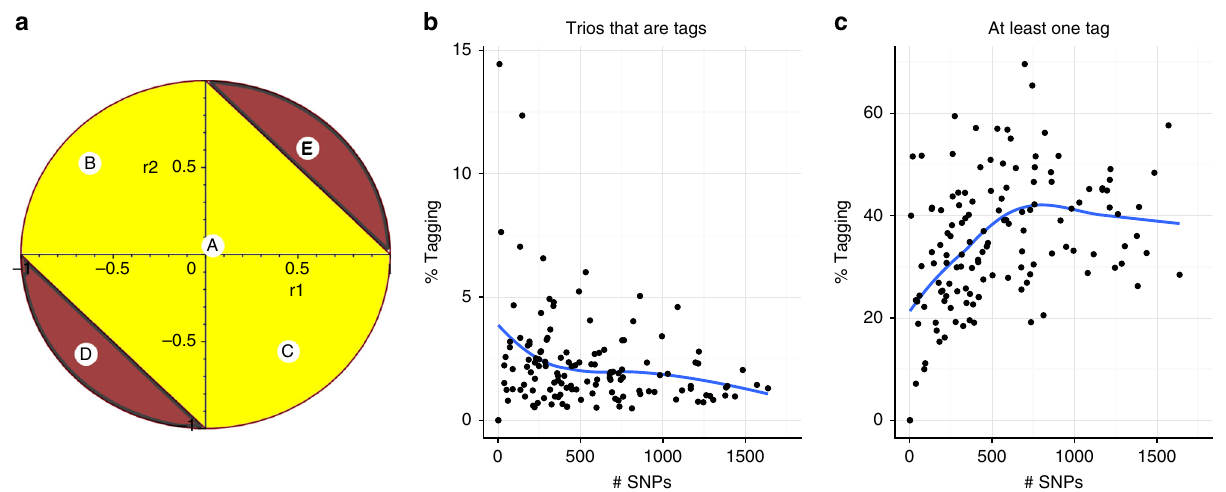
Fig. 2 Potential frequency of joint tagging. We consider the patterns of three-way LD between each possible trio of SNPs, nominating the fi rst two as causal, and the third as a potential tag. a For each pair of potential causal SNPs, we can predict whether the third SNP is a tag according to the pairwise correlation between that SNP and the two potentially causal SNPs (r1, r2). Red (yellow) areas indicate settings where the third SNP is (is not) a potential tag for SNPs 1 and 2. In this example, the potentially causal SNPs have equal MAF, equal effect on disease risk (equal odds ratios, OR) and are uncorrelated. Then, if the third SNP is (A) uncorrelated or weakly correlated with either SNP 1 or 2, or (B, C) negatively correlated with one and positively with the other, we would not expect it to act as a tag. On the other hand, if it were (D, E) strongly positively or negatively correlated with both causal variants, we would expect it to act as a joint tag. b shows the result of searching all possible SNP trios in UK ImmunoChip control data, and quantifying the proportion of trios that correspond to joint tagging in each region, assuming the causal variants have equal OR; the pattern is individually rare, consistently <5%. c shows the proportion of SNP pairs for which at least one potential tag exists, which can be substantial — about 40% overall. The blue curves show the loess fi ts to the points. Source data are provided in Supplementary Data